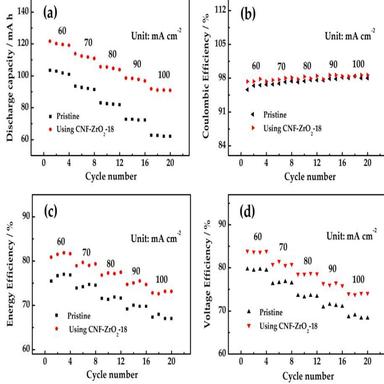
Discharge capacity (a), coulombic efficiency (b), energy efficiency (c) and voltage energy (d) of the cells with and without CNFeZrO2-18 from 60 to 100 mA cm2 .